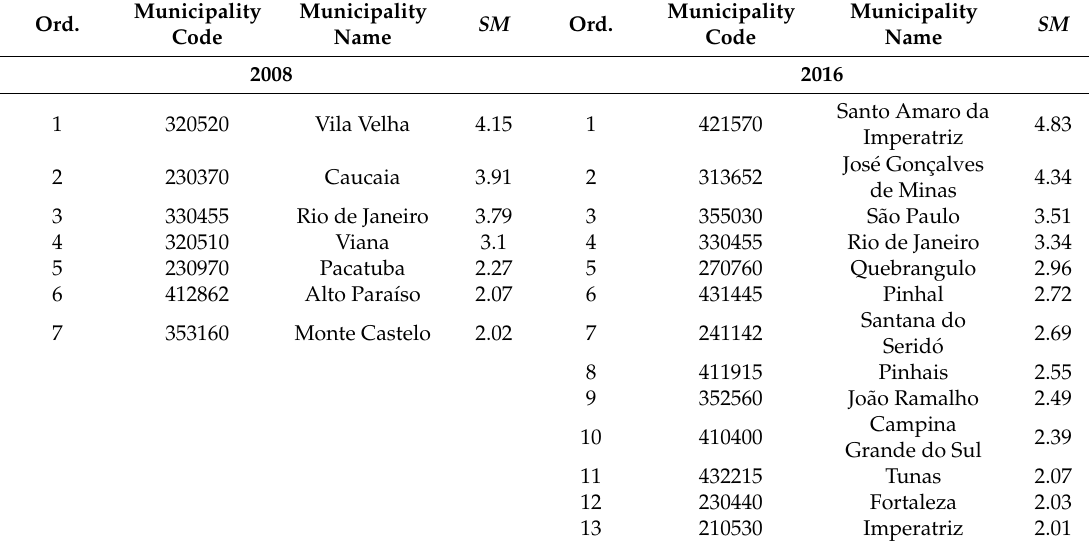
Table A5. Observations removed from the sample by using the super-e ffi ciency (SM) model to identify outliers, according to Banker and Chang [52].